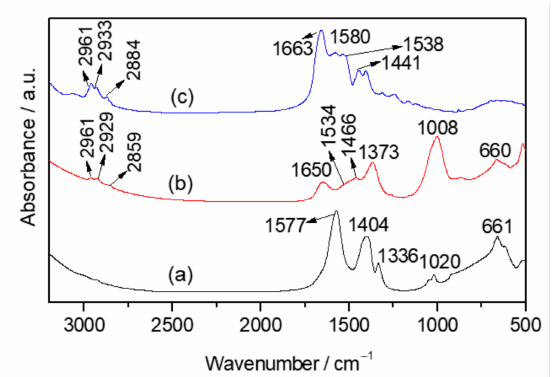
Figure 9. FTIR spectra in the 3200–500 cm − 1 region of pristine ( a ) Co 2 (OH) 3 (CH 3 COO)-LSH, the ( b ) Z-LSH_ie biohybrid. and the ( c ) Z-NaOH-US.